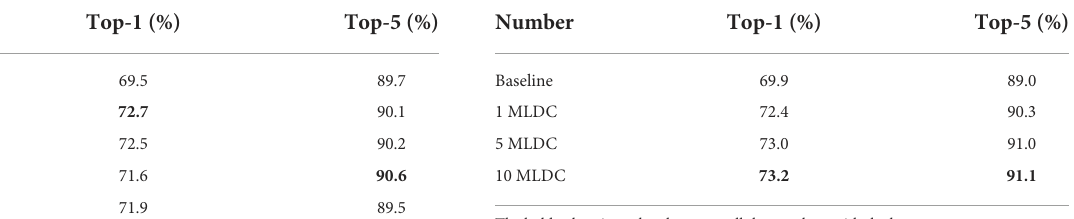
TABLE 2 Experimental results of executing multiple MLDC algorithms in ResNet network.